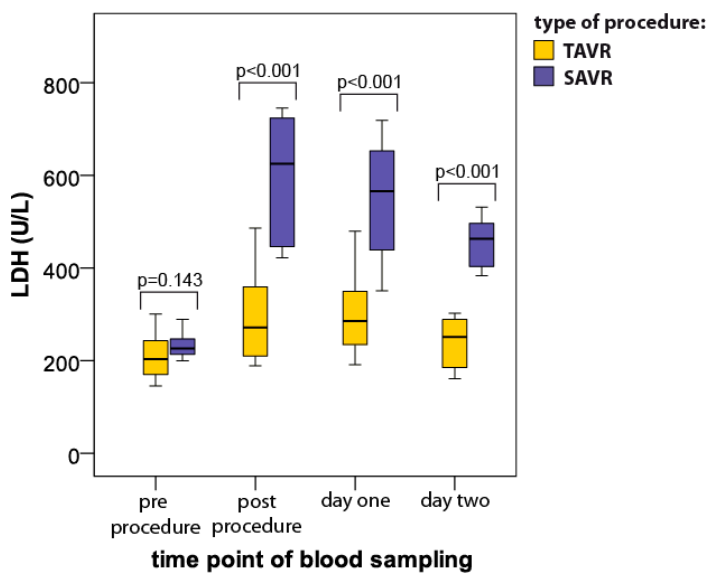
Figure 4. Serum lactate dehydrogenase (LDH) activity level (median with interquartile range) in patients undergoing TAVR ( n = 12) and SAVR ( n = 12) procedures.